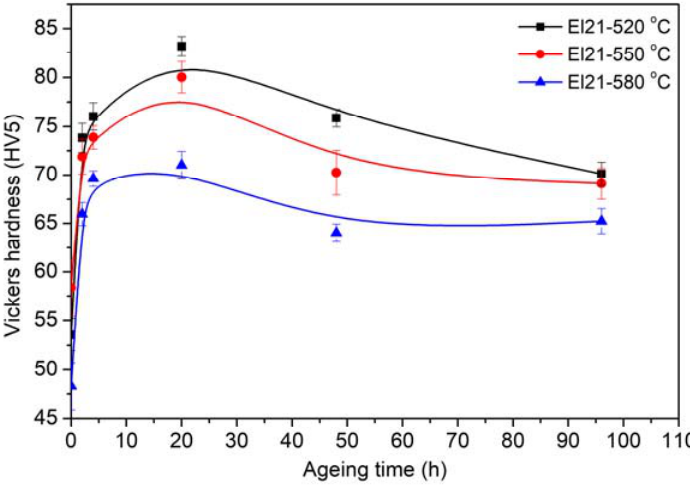
Figure 7. Hardness variation of El 21 solutionized at 520 °C, 550 °C and 580 °C then aged at 200 °C.